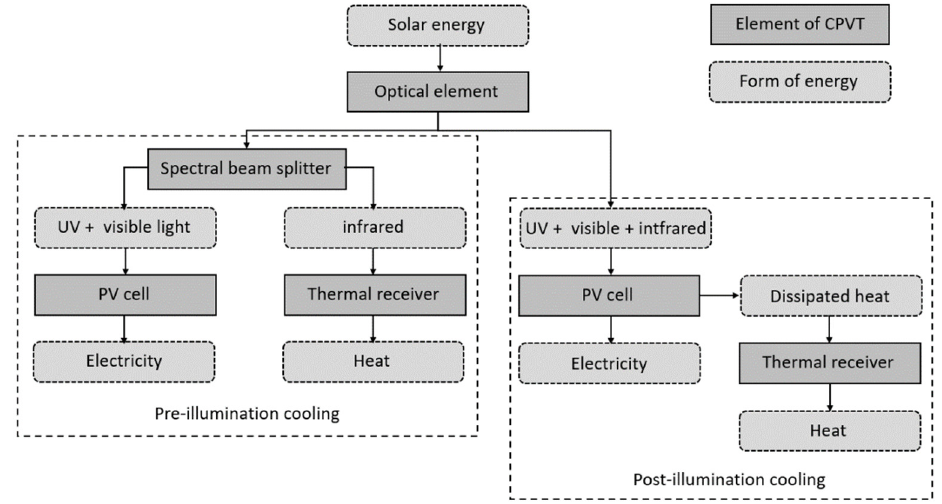
Figure 2. Energy flow in pre- and post-illumination cooling techniques.